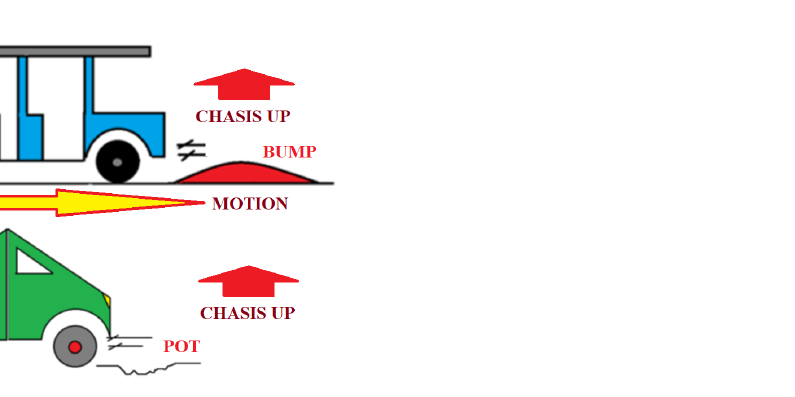
Figure 14. The frame of the car will be lifted up by a control action to deal with speed humps and speed